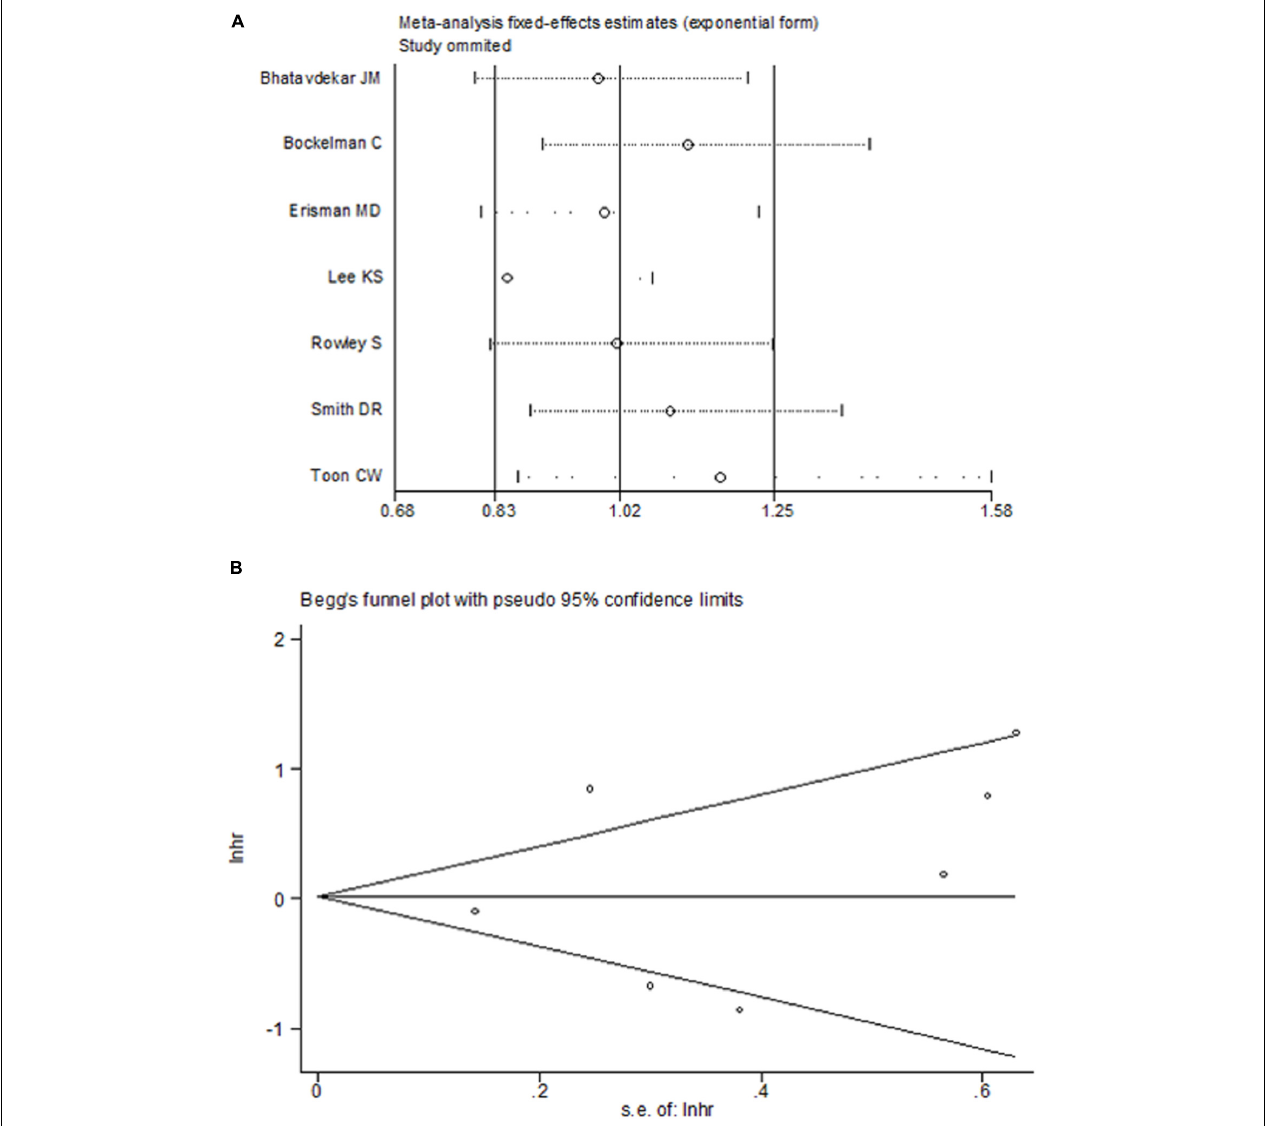
FIGURE 6 | Sensitive analysis (A) and Begg’s funnel plot (B) for the assessment of included studies in overall survival.